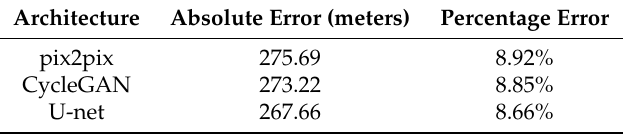
Figure 14. Qualitative comparison of performance on the test set for pix2pix [55], CycleGAN [57], and U-net [45]. To make the comparison as fair as possible, we present results after equal amounts of training time. Therefore, the ratio of epochs is roughly 1 : 0.6 : 0.17 for the U-net, pix2pix and CycleGAN respectively. It is evident that pix2pix achieves the most elaborate and accurate results compared to the competition. Note that the input satellite images were selected based on the complexity of the ground truth DEMs and not based on the performance of the models and that no data augmentation (Section 2.8) was used for this comparison. Therefore, these results are not indicative of an optimal state of the models and we have to extrapolate on the performance on bigger datasets. Representative results for pix2pix can be found in Figure 8. A quantitative comparison is presented in Table 3. Table 3. Absolute (in meters) error and percentage error with respect to the total range of the pix2pix, CycleGAN and U-net. To make the comparison as fair as possible, we present results after equal amounts of training time. Therefore, the ratio of epochs is roughly 1:0.6:0.17 for the U-net, pix2pix and CycleGAN respectively. Notice that producing sharp results (Figure 14) does not correlate well with quantitative performance, presumably due to overfitting. For the U-net especially, this can be attributed to the diminished capacity resulting from its simpler architecture, as we demonstrate in Section